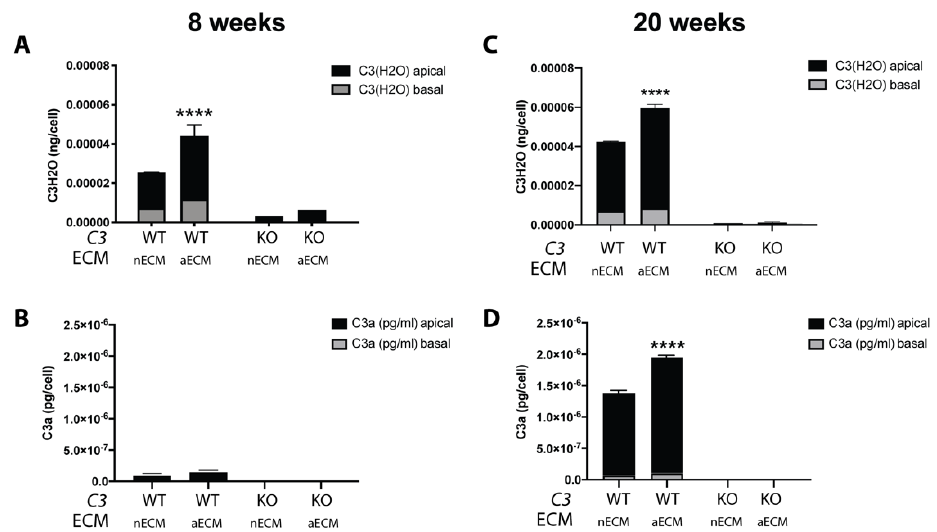
Figure 2. AMD-like substrate increases activation of C3 by hydrolysis. Histograms represent the levels of C3(H 2 O) and C3a measured with ELISA in the apical and basal conditioned media of iPSC-RPE C3 WT/WT cells and iPSC-RPE C3 KO/KO cells grown on transwells coated with nECM or aECM for ( A , B ) 8 or ( C , D ) 20 weeks. Data was normalized to cell counts. (Data represented as mean ± SD. n = 4 transwells/type of culture. 2-way ANOVA, **** p < 0.0001).